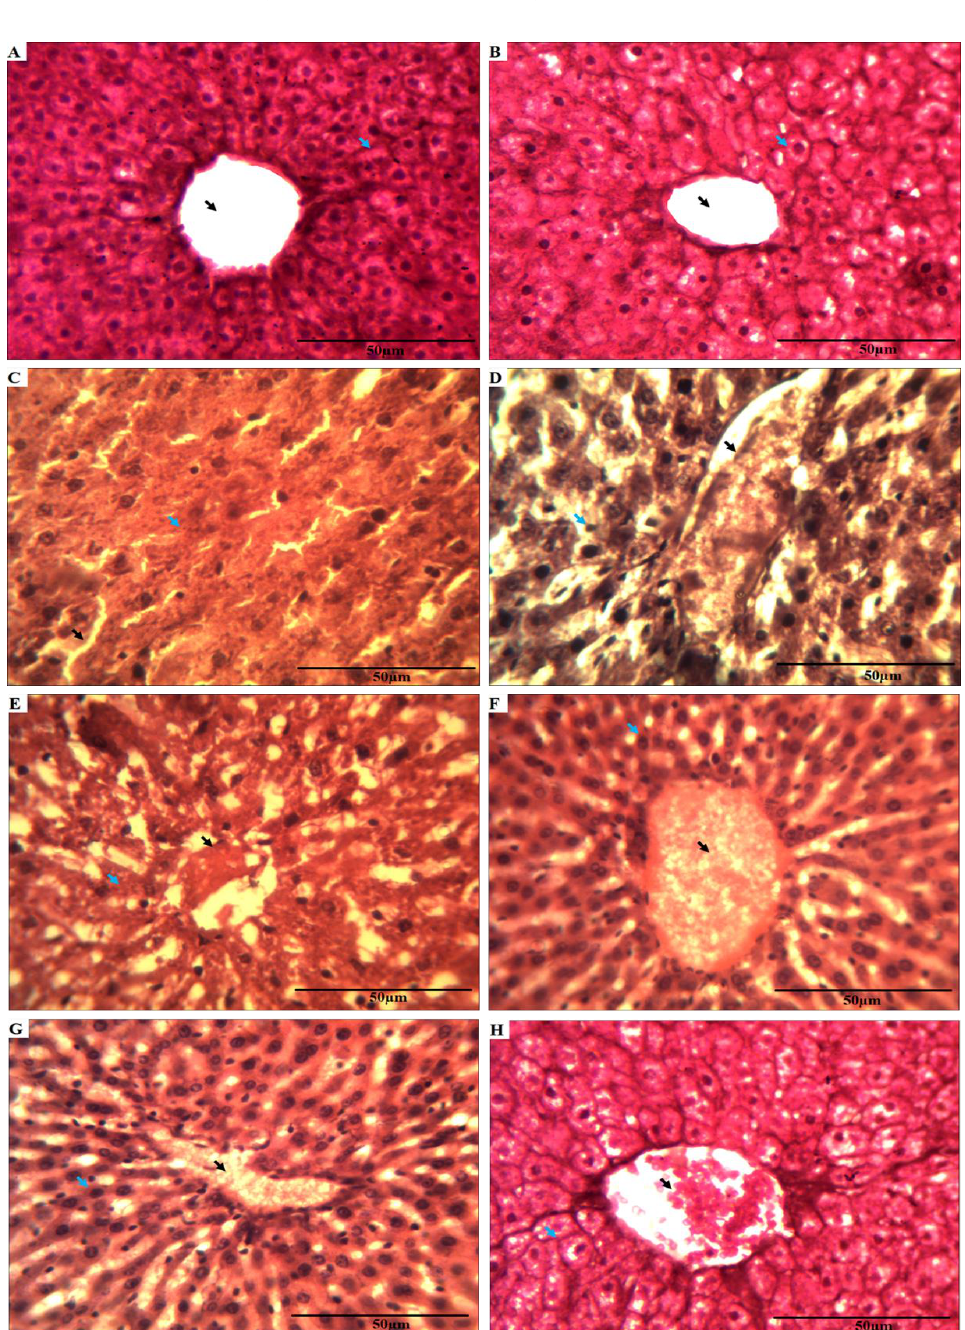
Figure 4. Histological images of rat liver exposed to pesticides and aqueous extract from A. vera leaves for 15 days. Photomicrograph of a tissue from ( A ) C group, ( B ) AE + C group, ( C ) Ctp challenged group, ( D ) Mtn challenged group, ( E ) Ctp + Mtn challenged group ( F ) AE + Ctp treated group, ( G ) AE + Mtn treated group, ( H ) AE + Ctp + Mtn treated group. The black arrow indicates changes in central vein, and the blue arrow indicates the disorganization in hepatic cells. Abbreviations: C: Control, AE